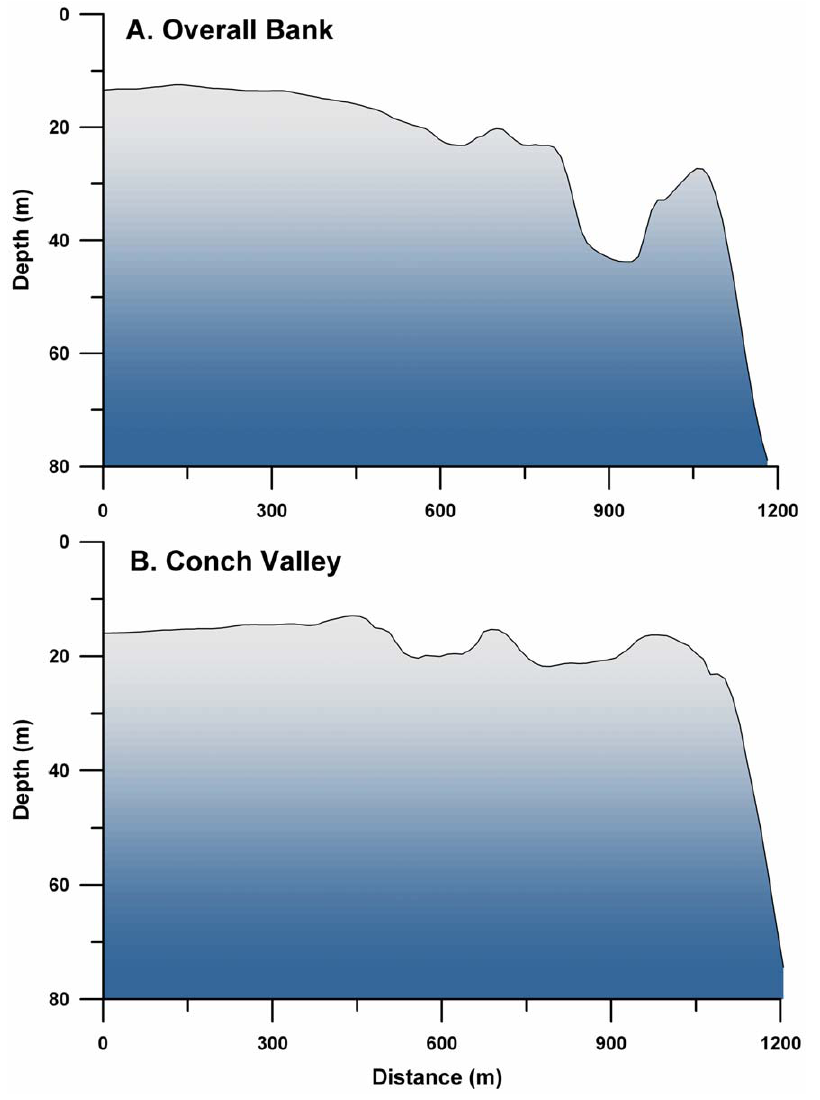
Figure 2. Depth profiles of the Saba Bank platform edge. Profiles of platform edge ‘‘fore-reef’’ dive sites on Overall Bank (A7, A12 in Figure 1) and in the Conch Valley (CV1, CV2 in Figure 1). Each fore-reef is bounded on the interior by a trough of varying depth and character. Troughs were generally sandy, with intermittent patch reefs.